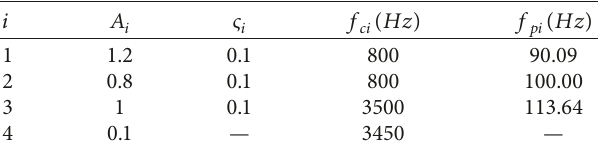
Figure 2: Flowchart of the proposed CPS. Table 1: Parameters related to simulation